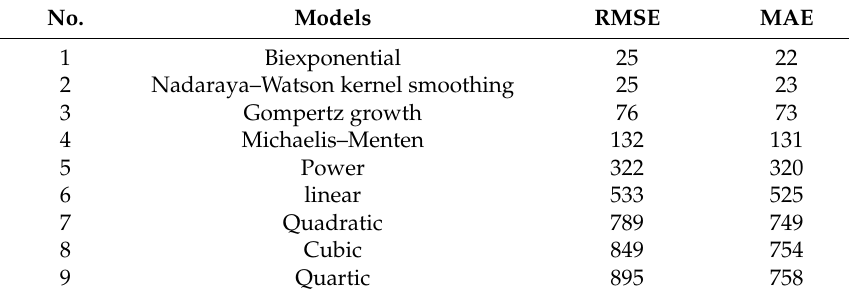
Table 4. Results of leave-last-five-out